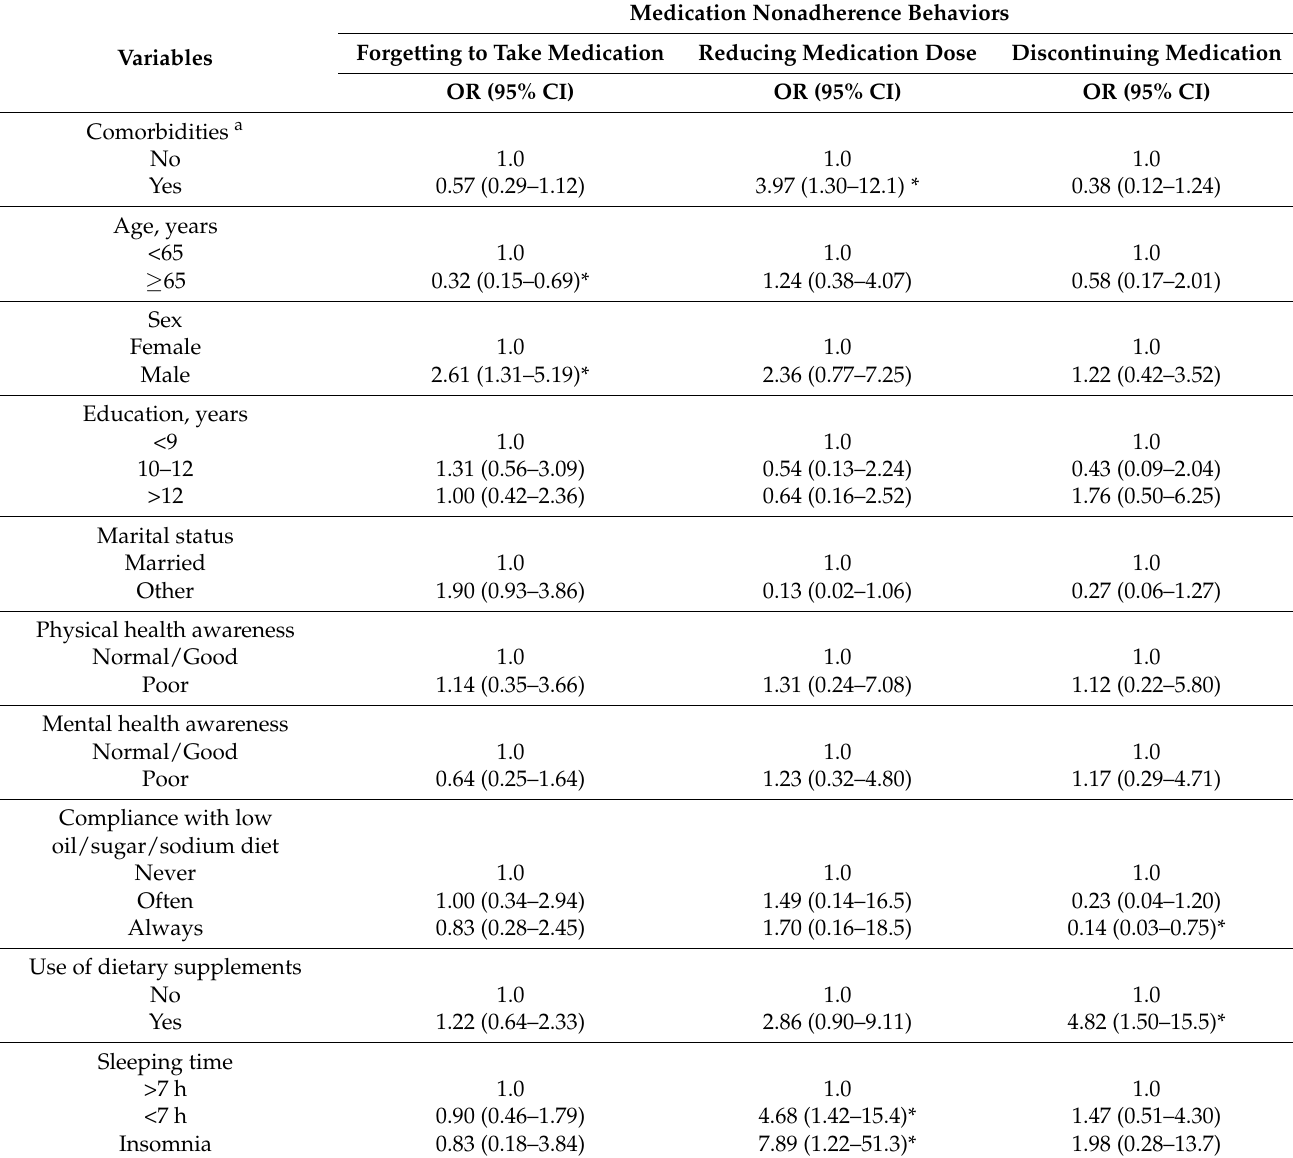
Table 3. Multivariable logistic regression analysis of factors associated with specific behaviors of nonadherence to antihy- pertensive